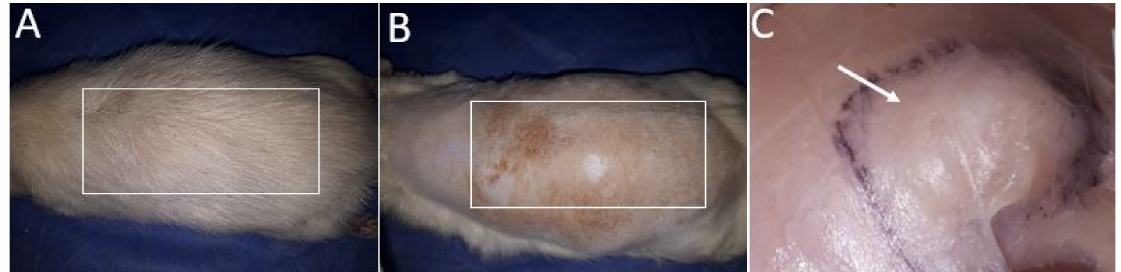
Figure 6. Implantation zone at the dorsal area in Wistar rats after 30 days of subcutaneous implantation: ( A ) hair recovery, ( B ) absence of injuries and infections, and ( C ) internal surface of the skin where the implanted samples are encapsulated by scar tissue. Rectangle: Area of implantation. Arrow: encapsulation